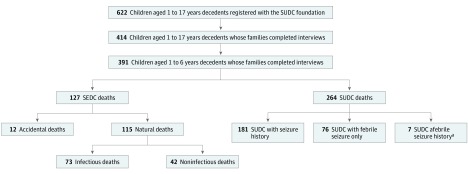
Categorization of Data SetSEDC indicates sudden explained death in childhood; and SUDC, sudden unexplained death in childhood.aOne decedent also had a history of simple febrile seizures.